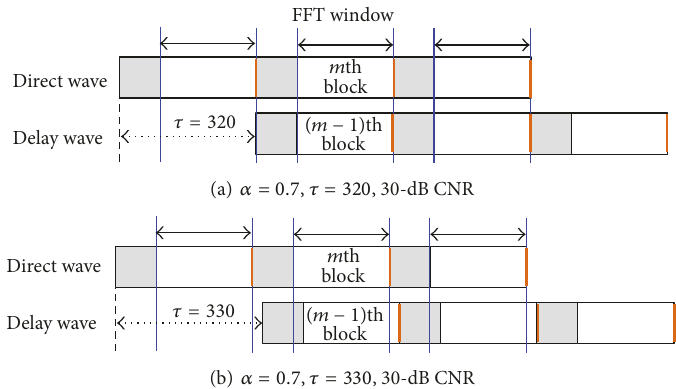
Figure 4: Relations between direct and delay waves ( 𝜏 = 320 and 𝜏 = 330 ).